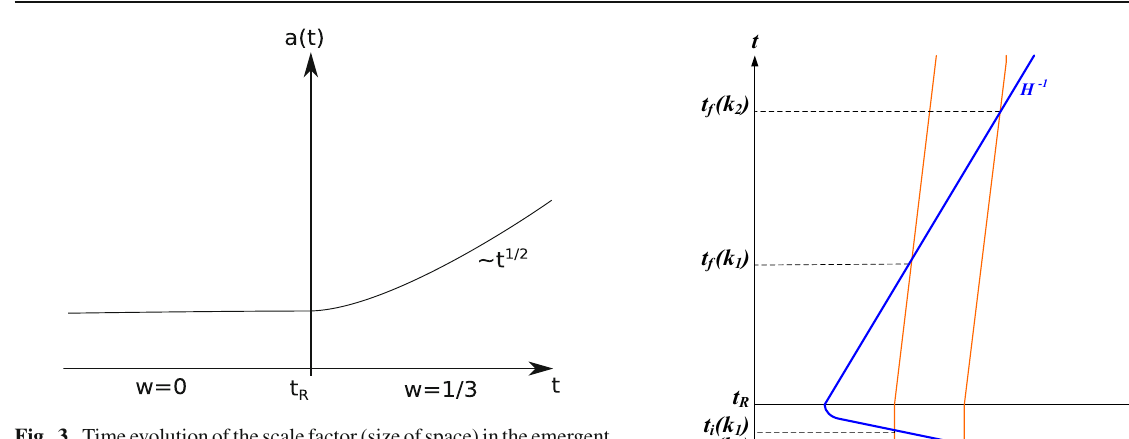
Fig. 3 Timeevolutionofthescalefactor(sizeofspace)intheemergent universe scenario. The time axis is the horizontal axis, the vertical axis gives the value of the scale factor. The time t R is the end of the emergent phase, the time when the universe makes the transition to the radiation stage of Standard Cosmology during which the scale factor increases as the square root of time